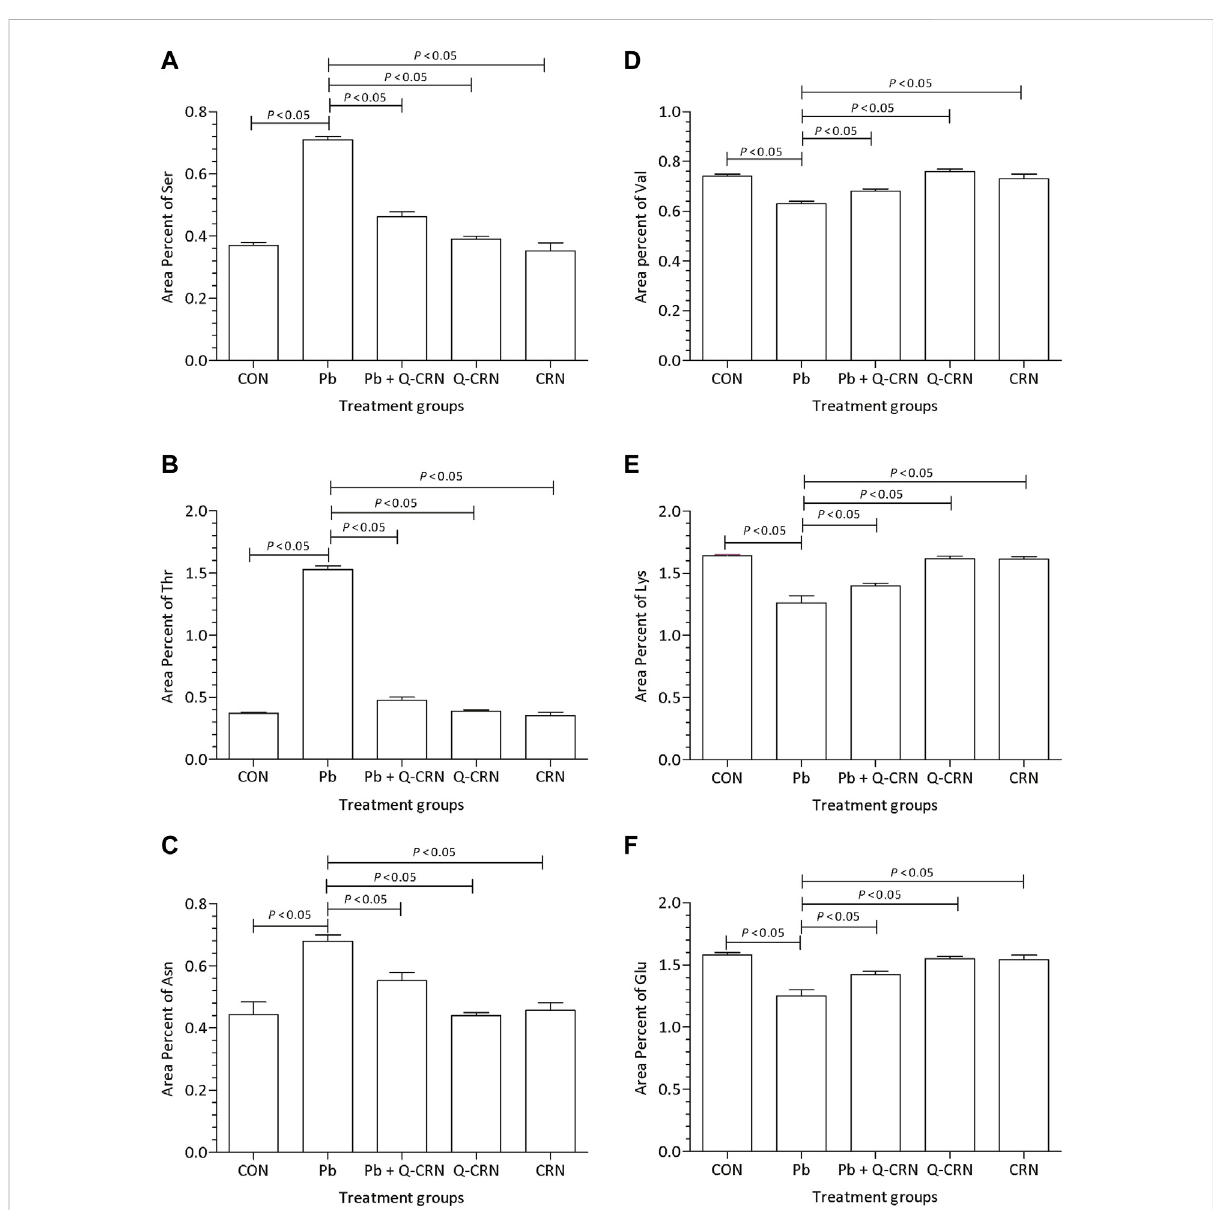
FIGURE 5 EffectofintoxicationofPbAconareapercentof (A) serine, (B) threonine, (C) asparagine, (D) valine,I (E) lysine,and (F) glutamicacidintheplasma ofdifferentmicegroups,i.e.,CON,Pb,Pb+Q-CRN,Q-CRN,andCRNgroups,respectively.Thequantitativeanalysiswascarriedoutattheendofthe experimentof28 days.Thesigni fi cancelevelwassetat( p < 0.05)byusingone-wayANOVAfollowedbyTukey ’ stesttocompareallpairsofcolumns. Each error bar represents the mean ± SD. Abbreviations: Ser: serine; Thr: threonine; Asn: asparagine; Val: valine; Lys: lysine; Glu: glutamic acid; CON: control group; Pb: lead group; Pb+ Q-CRN: lead and quercetin blended in corn oil group; Q-CRN: quercetin blended in corn oil group; CRN: corn oil group ANOVA: analysis of